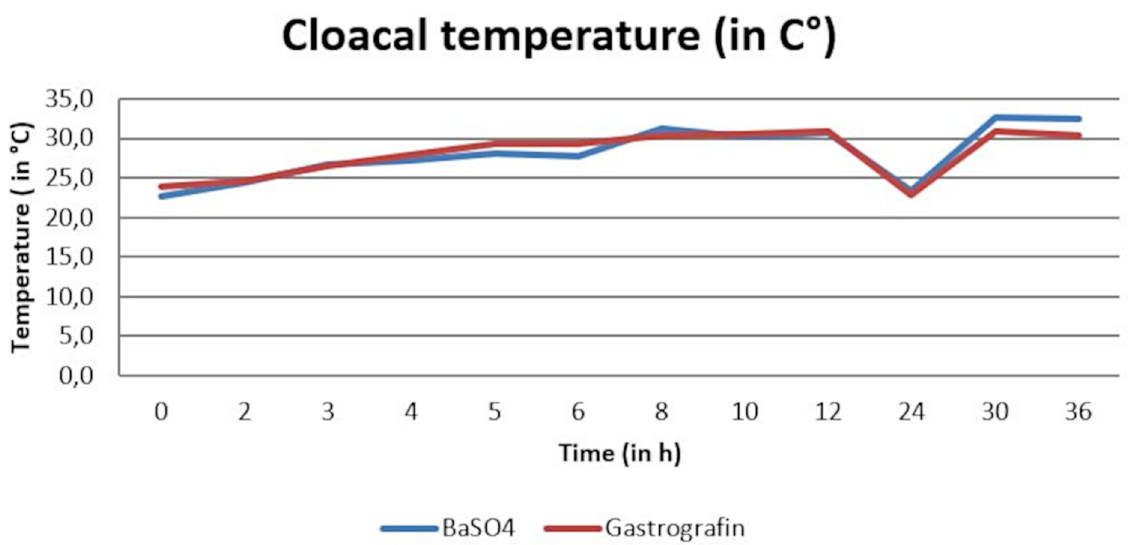
Fig 4. Arithmetic mean of cloacal temperature (in˚C) during the barium sulfate and Sodium/Meglumine–Amidotrizoate (SMAT, Gastrografin) contrast passage.